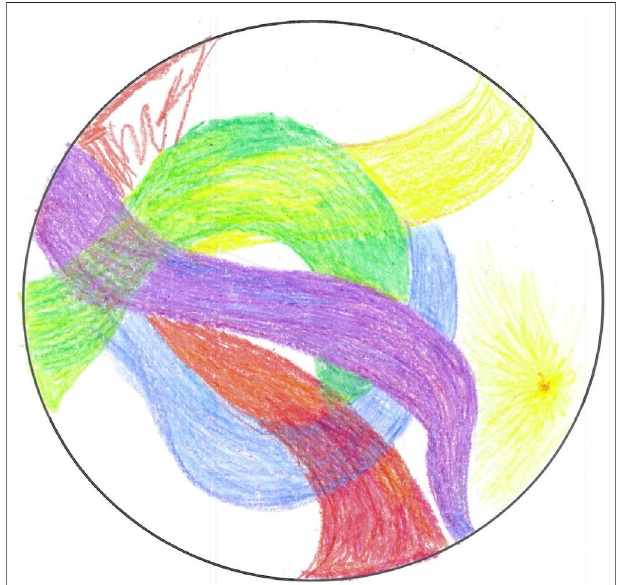
FIGURE 8 | My inner vision became the universe, fi lled with colourful waterfalls,glisteninglikestars,notboundbygravity. They fl oatedintheairand folded around each other. Totally quiet. The streams were in fi nite and beautiful. Report 15, female, CME, MEQ total 3.5.